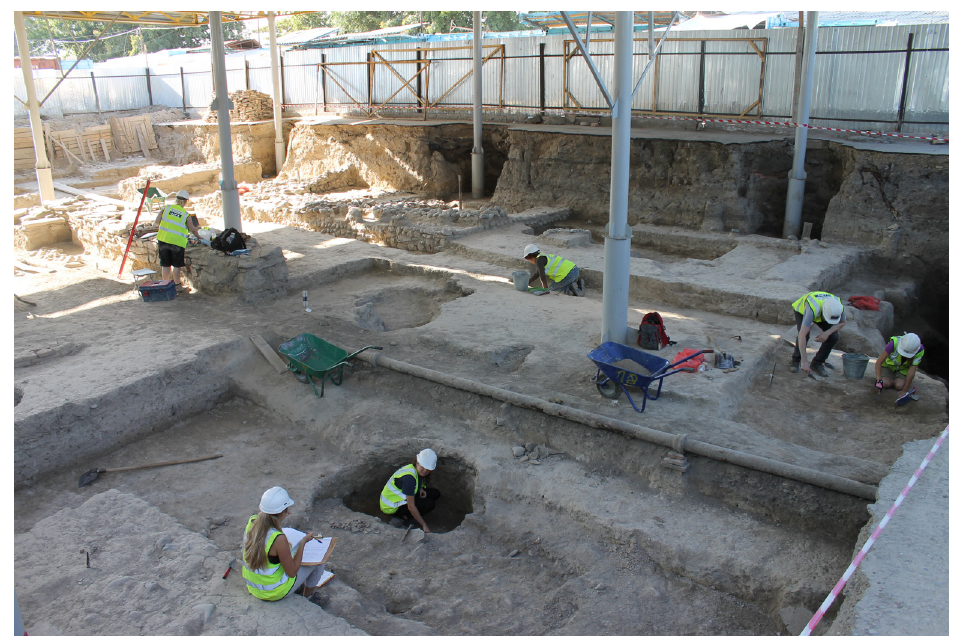
Fig. 4: UCL students excavating at Taraz under the purpose-built shelter. Phase 3: 10th-12th centuries; Building